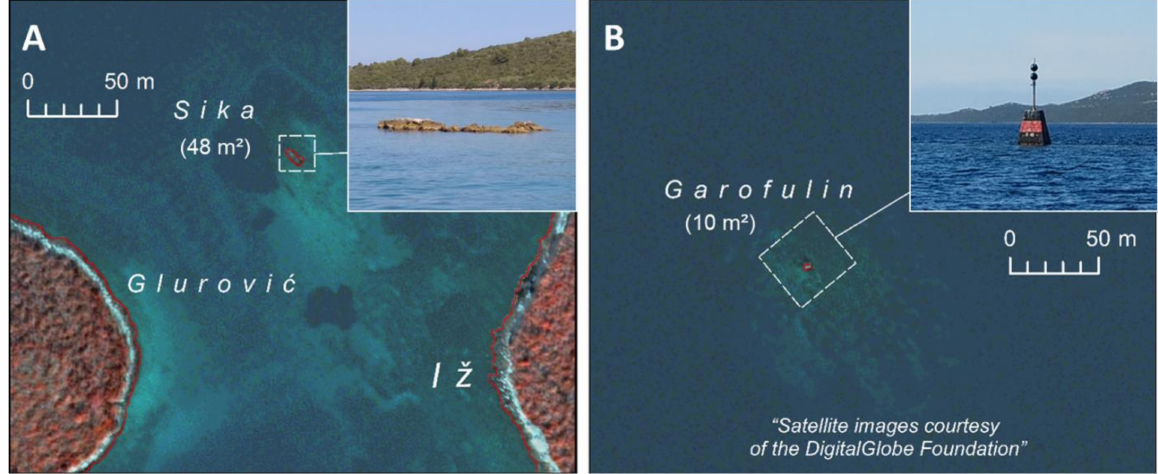
Figure 9. Two very small rocks successfully mapped by CET from WV-derived models.